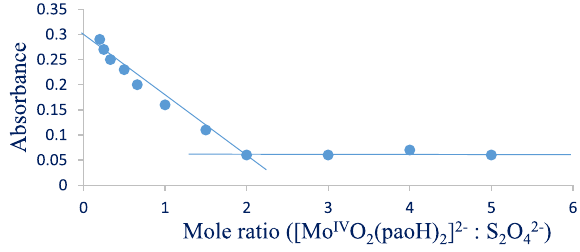
Figure 1. Reaction stoichiometry of [Mo IV O 2 (paoH) 2 ] 2− and S 2 O 42− at [Mo IV O 2 (paoH) 22− ] = 13.0 × 10 – 4 mol dm −3 and T = 303